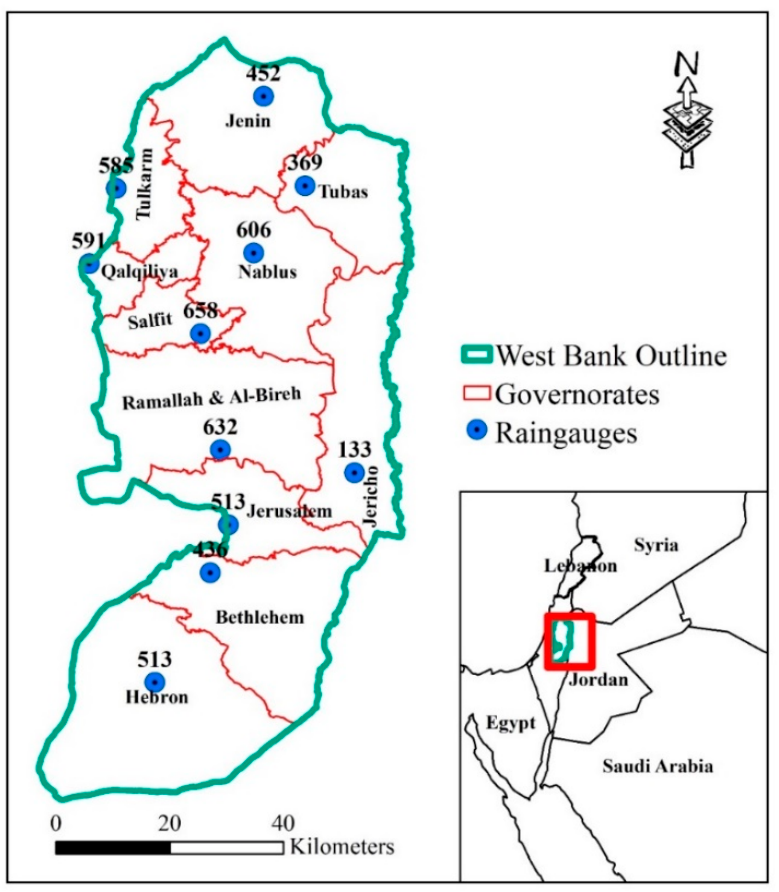
Figure 1. The regional location map of the West Bank together with the long-term annual average rainfall (in mm).